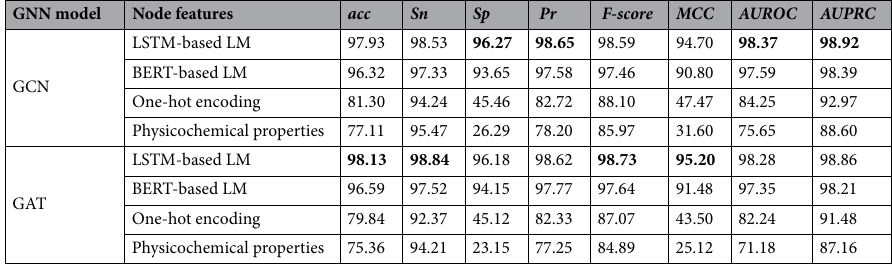
Table 3. Performance of GNN variants using different node features on human test set. Best values are in bold.